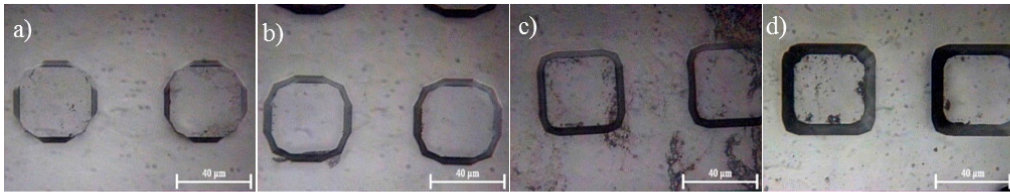
Figure 11. Microscopic inspection of a 22 wt % KOH wet etch process after 20 min. Initial profile: 40 μm squares aligned with the wafer flat. Conditions are described in Table 1: ( a ) Sample 1; ( b ) Sample 2; ( c ) Sample 3; and ( d ) Sample 4.